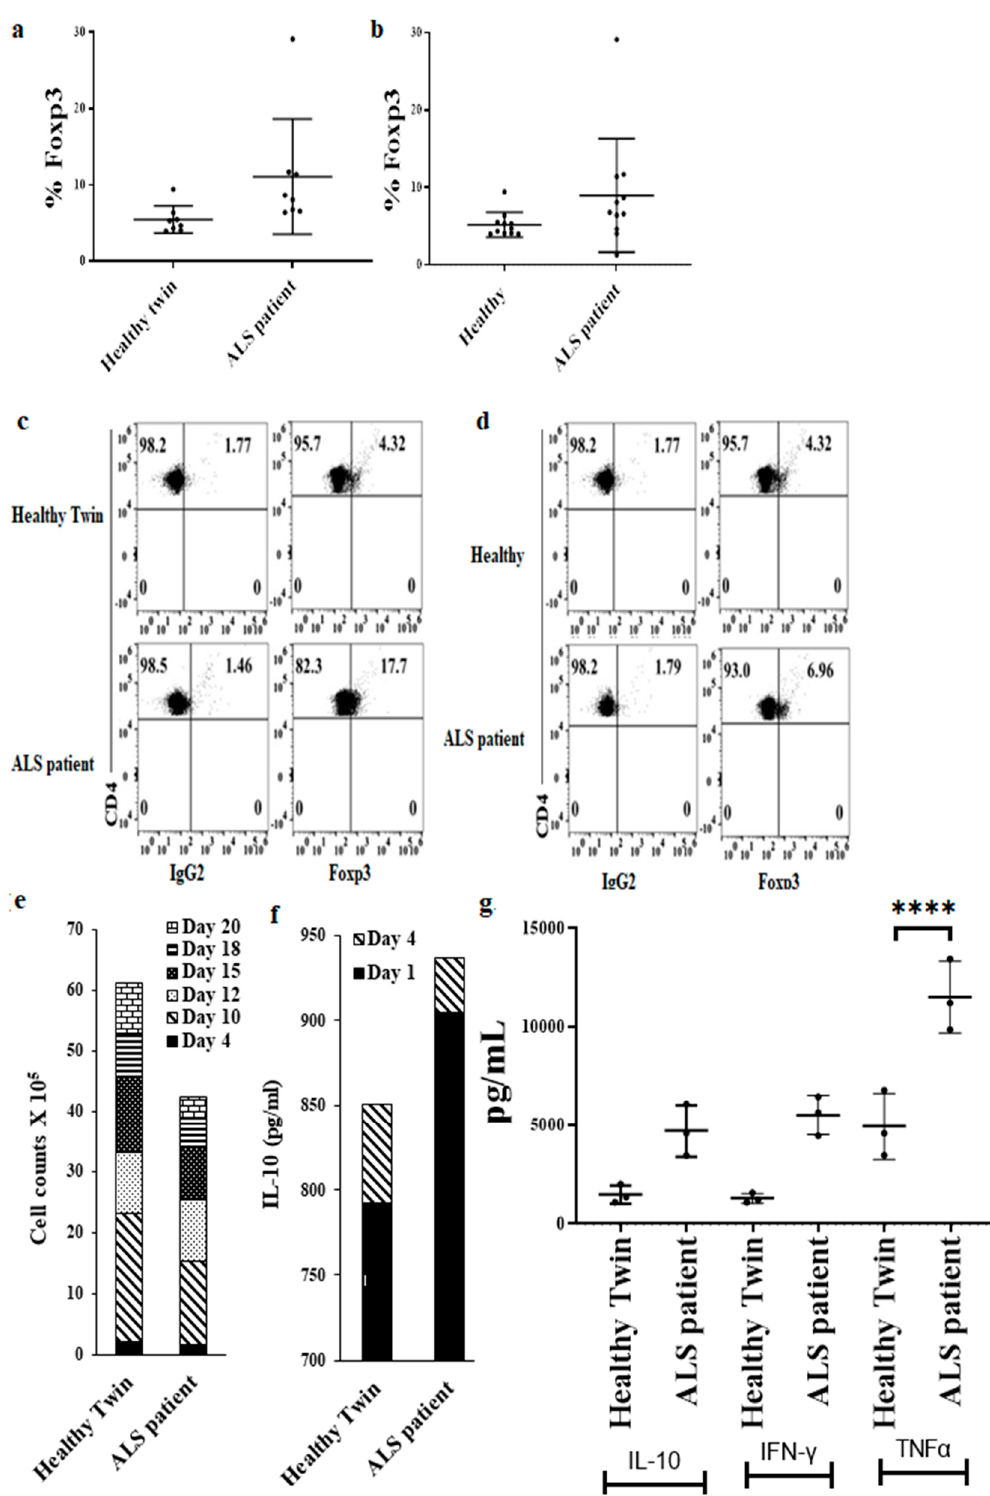
Figure 8. Increased regulatory CD4+ T cells in PBMCs of ALS patients in comparison to healthy individuals. PBMCs of healthy individuals and ALS patients were isolated from peripheral blood as described in Section 2. PBMCs (2 × 10 5 cells) were used to determine the percentages of Foxp3 using flow cytometric analysis. IgG2 isotype control antibody was used as control (( a ) ( n = 8), ( b ) ( n = 11)). PBMCs (2 × 10 5 cells) were used to determine the percentages of CD4+Foxp3+ using flow cytometric analysis. IgG2 isotype control antibody was used as control ( c , d ). CD4+ T cells of healthy individuals and ALS patients were isolated from PBMCs as described in Section 2. For Treg differ- entiation, naïve CD4+ T cells (1 × 10 6 cell/mL) were cultured with ImmunoCult-XF T cell expansion